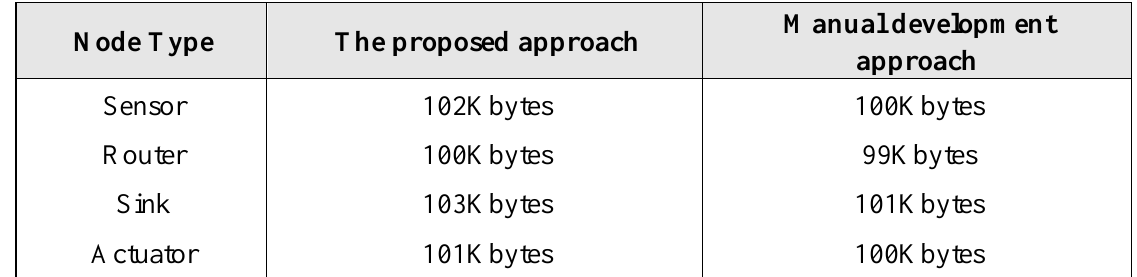
Table 6. The memory size of execution